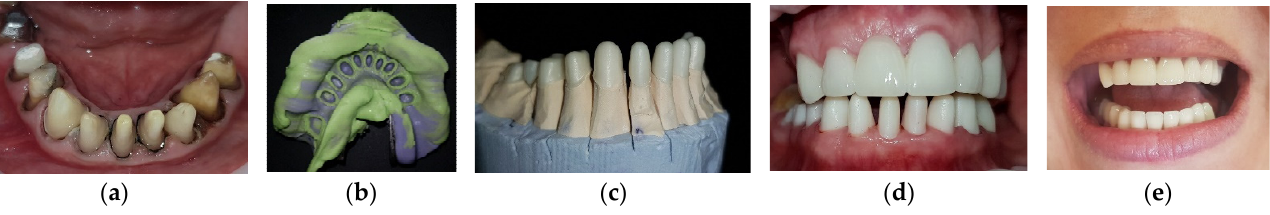
Figure 8. The steps of the prosthodontic rehabilitation: ( a ) The prepared abutments with the first impression cord; ( b ) One step impression with A silicone; ( c ) The zirconia frame on the master cast; ( d ) The try-in of the zirconia frame; ( e ) The final restoration after cementation. For the restoration of the edentulous space on the lower arch, implant therapy was applied. Two implants were